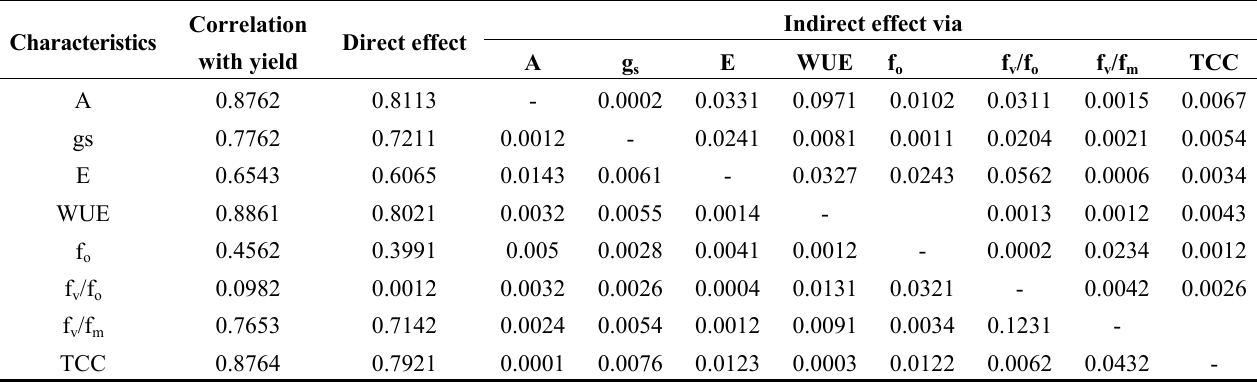
Table 7. Path coefficient analysis showing direct and indirect effects of biochemical characteristics with rice